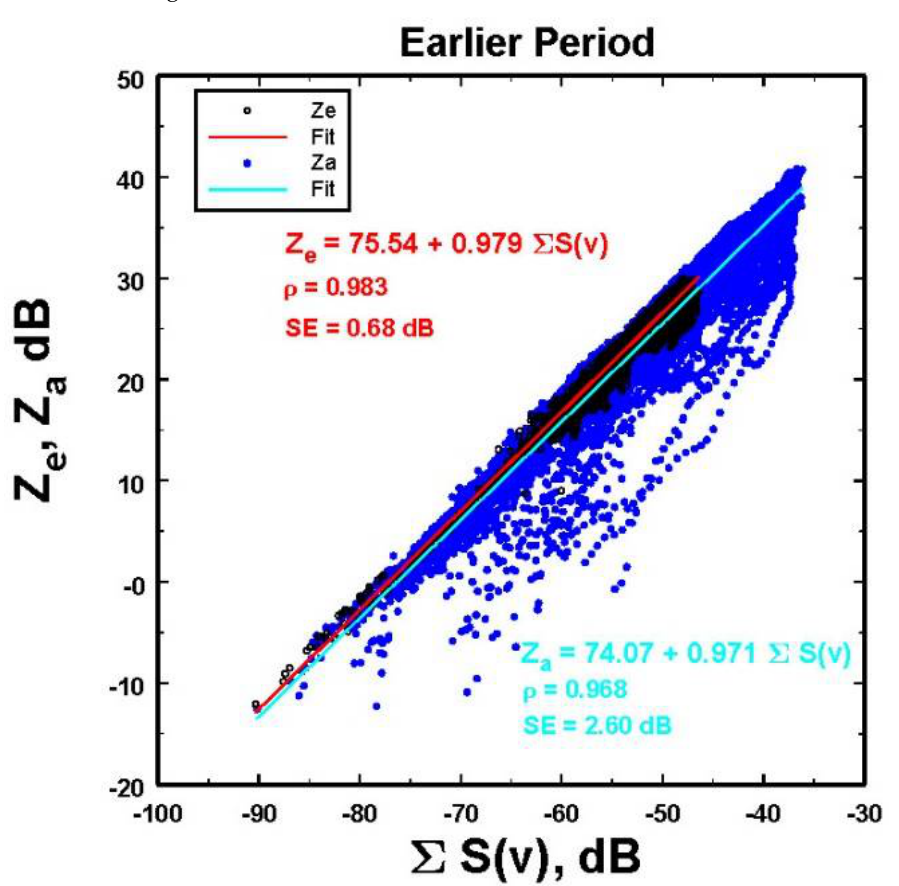
Figure A2. Linear fits of the logarithms of the MRR-reported equivalent radar reflectivities, Ze, and the attenuated reflectivities vs. the logarithms of the summations over the reported Doppler spectral powers. SE is the standard error of the fits.